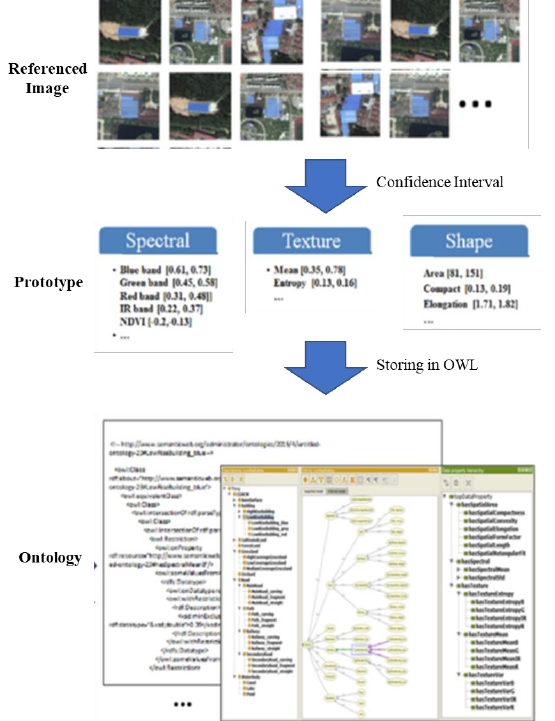
Figure 2. Create prototype of Land cover for Beibuwan Gulf. With the help of referenced image and land cover map, the confidential interval of each feature can be calculated. And then all these data are stored in Protégé 3.4.7.